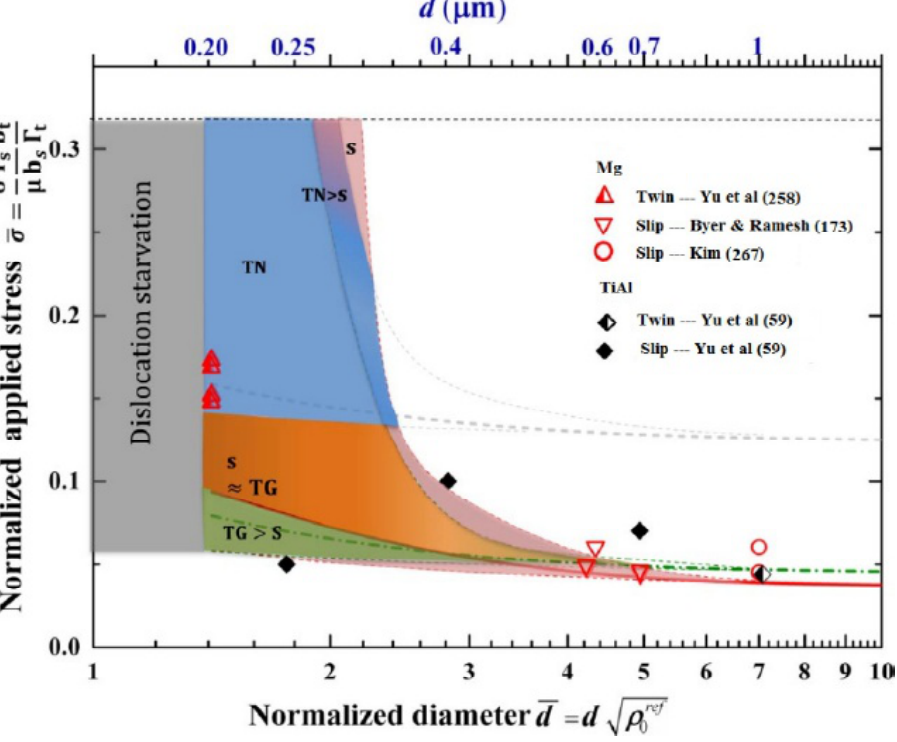
Fig. 38. Mechanism map incorporating all deformation modes of hcp single crystals (slip, twin nucleation and twin growth) based on a 95% deviation of the weakest source distribution as function of sample diam- eter d and applied stress. The symbols in red represent the normalized experimental data of Mg and the black symbols denote the normalized experimental data of Ti alloy. The open symbol indicates that initial yield is attributed to the slip mode and half-filled symbol indicates that initial yield is attributed to the twinning mode. Reprinted with permission from Zhang J, Ramesh KT, Joshi SP. 2014. Stochastic size- dependent slip-twinning competition in hexagonal close packed single crystals. Modelling and Simulation in Materials Science and Engineering 22, [66]: © Copyright 2014 IOP